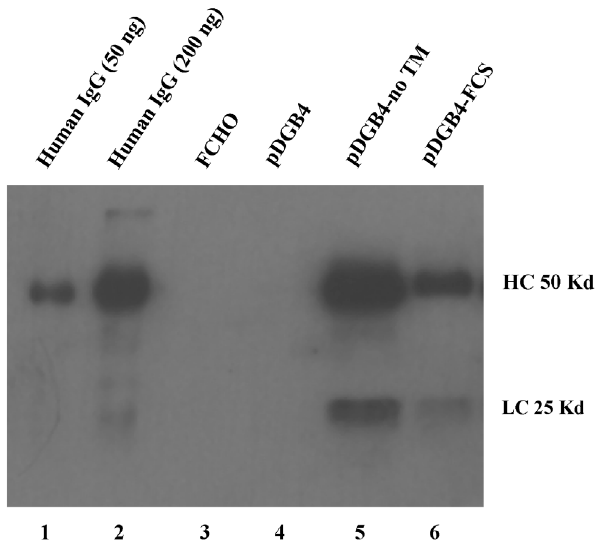
Figure 5. Western blot analysis of antibodies in conditioned media. Conditioned media were collected from stable transfected Flip- In CHO (FCHO) cells and concentrated 10-fold. Ten m l each were analyzed by electrophoresis with 10% SDS-PAGE gel. Lane 1: human IgG 50 ng; lane 2: human IgG 200 ng; lane 3: FCHO; lane 4: pDGB4; lane 5: pDGB4-noTM; and lane 6: pDGB4-FCS.